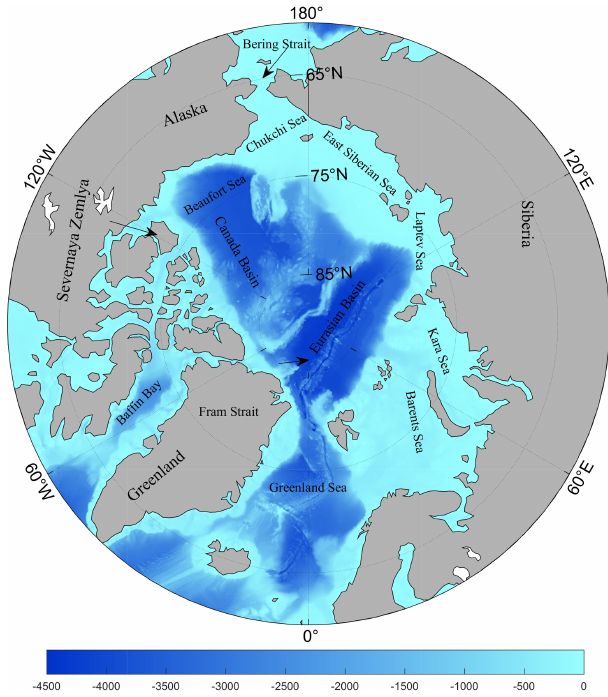
Figure 1. Geographic map of the Arctic and its adjacent seas (the shading represent the water depth in